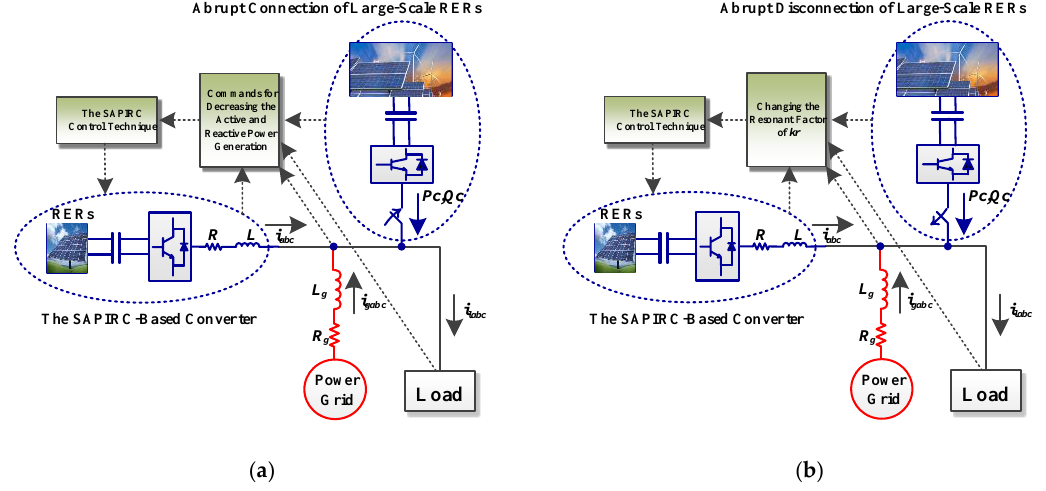
Figure 8. Operation of the SAPIRC-based converter under high penetration of RERs: ( a ) under a sudden connection, and ( b ) different values of the resonant factor under sudden disconnection.